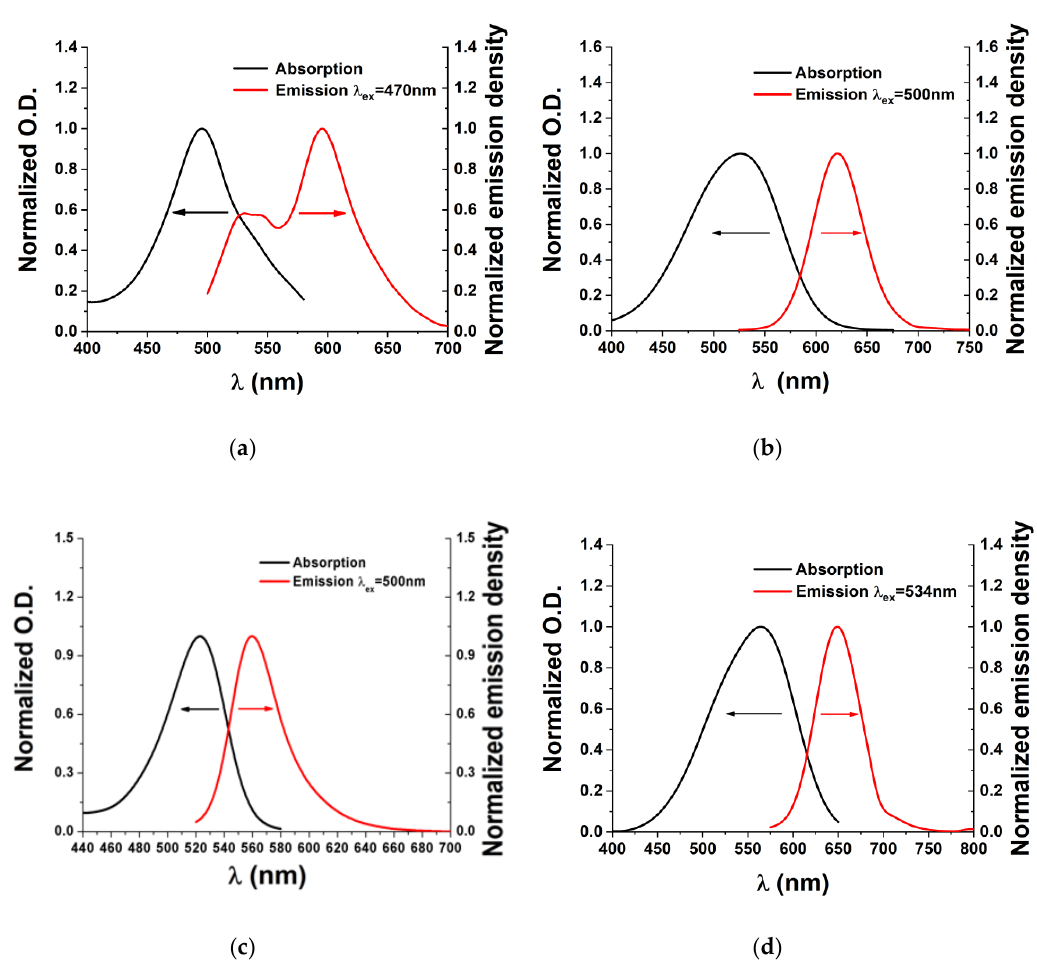
Figure 8. Singlet state energy determination in acetonitrile for: ( a ) dye 5 ; ( b ) dye 9 ; ( c ): dye 17 ; ( d ) dye 19. Table 3. Parameters characterizing the chemical mechanisms associated with dyes 5 , 9 , 16 , 17 , 19 in acetonitrile a .